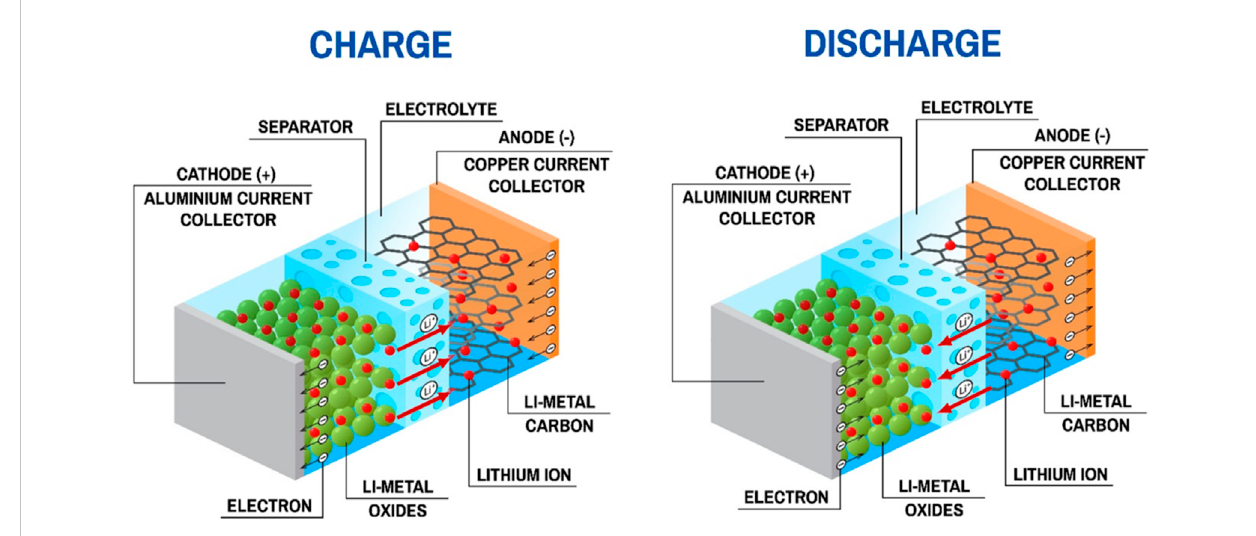
FIGURE 4 Con fi guration and working principle of